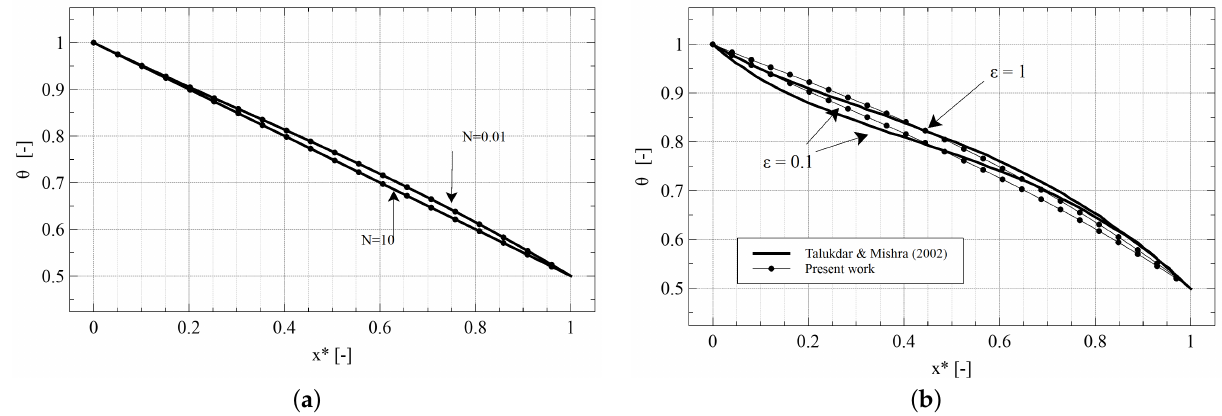
Figure 8. Comparison between the 1D window model results and reference results reported by Talukdar and Mishra [39]: ( a ) influence of conduction-radiation parameter; and ( b ) influence of